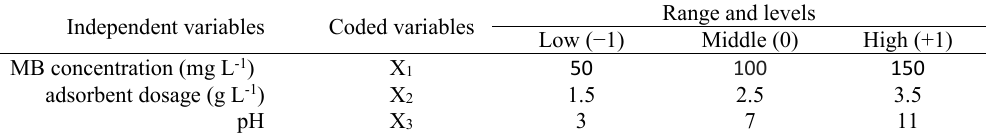
Table 1. Experimental range and factor level of process variables applied in the experimental design. Independent variables